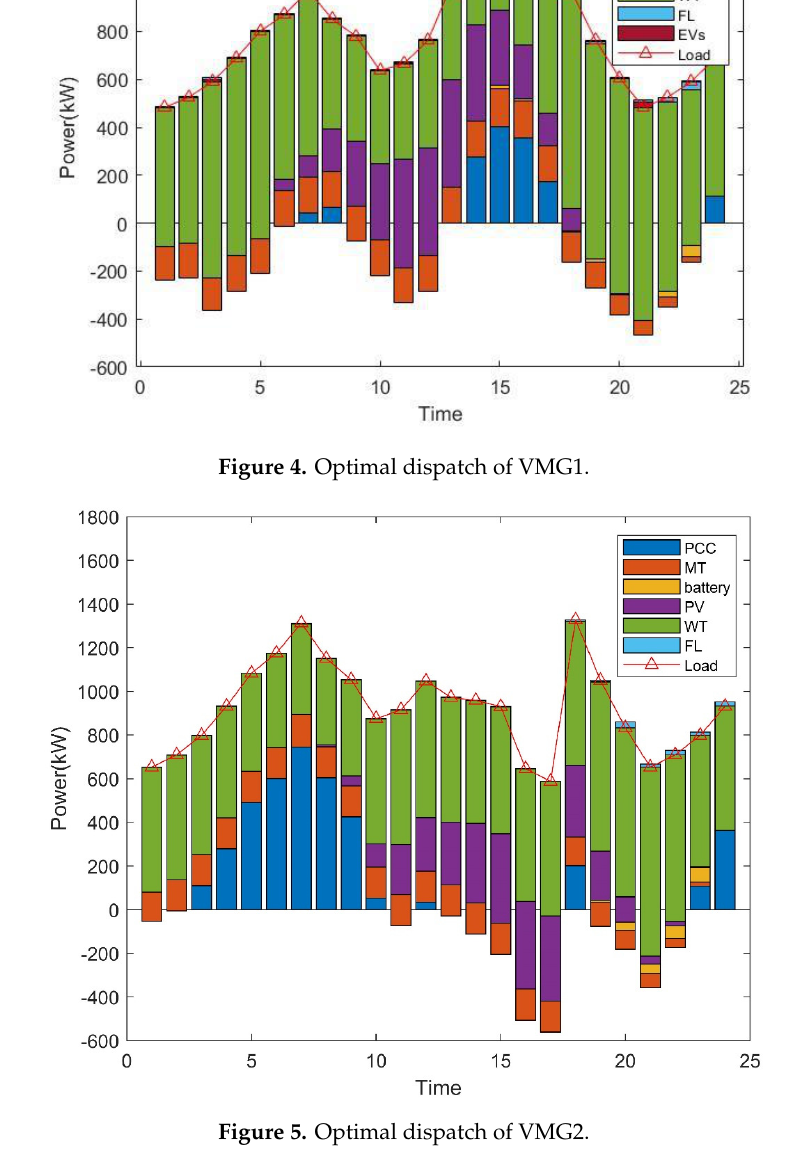
Figure 5. Optimal dispatch of VMG2.